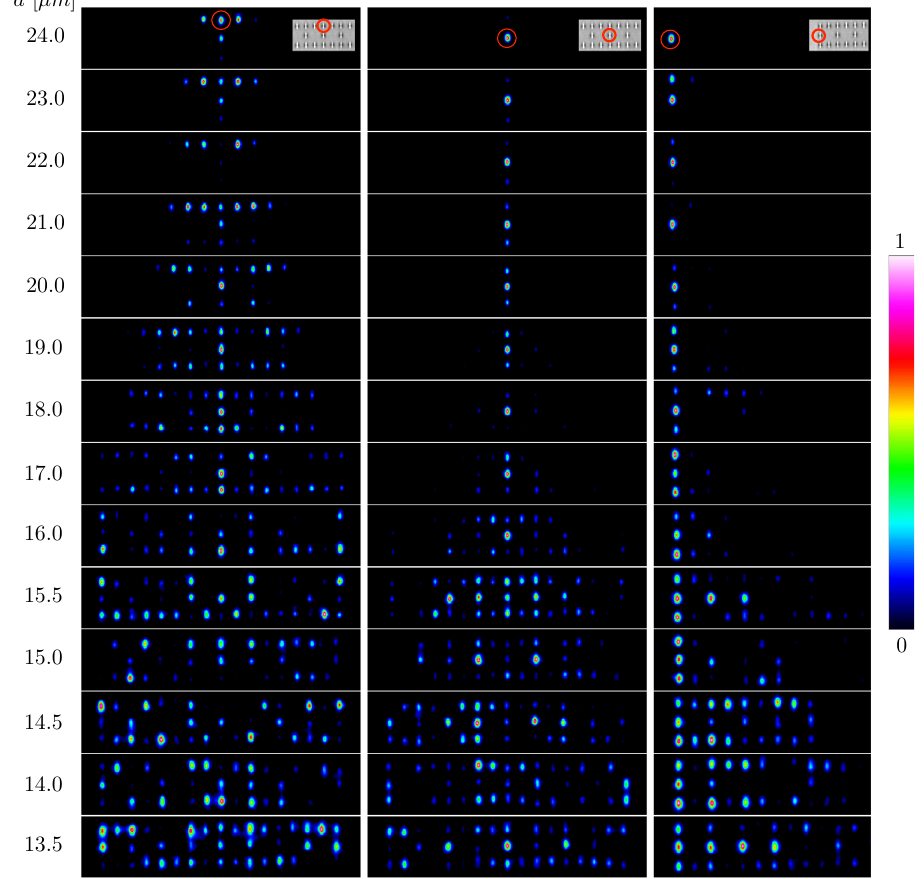
Figure 4. Left, center and right columns show the experimental output intensity pattern for A -bulk, B -bulk, and B -edge input excitations, as indicated at insets by red circles. Nominal distance d decreases downwards, as indicated directly beside left column. The aspect ratio was corrected to compare different lattices on a similar visual scale. A rainbow-like color scale is applied, which is normalized to the peak power of every image. This figure was drawn using Thorlabs’ Beam 8.0 and Omnigraffle